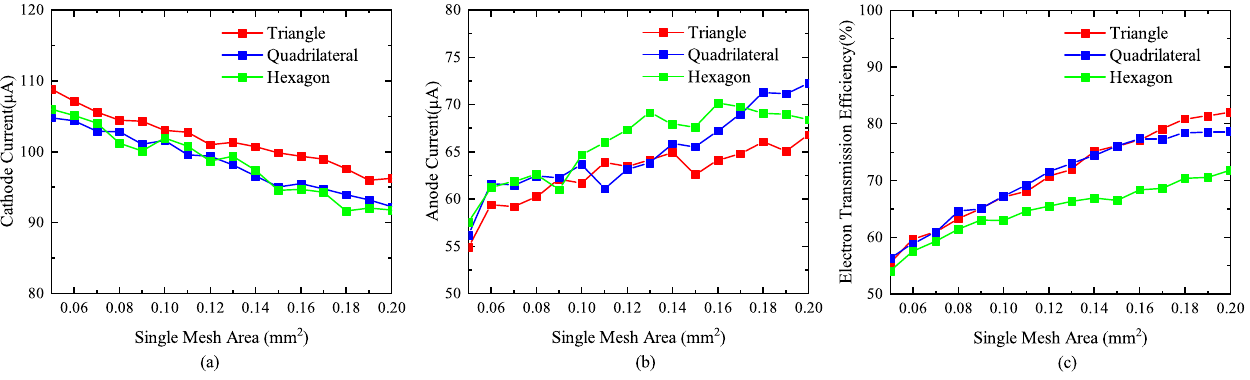
Figure 5. Relationship of single-grid-mesh area with cathode current, anode current, and electron transmission efficiency. ( a ) Effect of single-mesh area on cathode current. ( b ) Effect of single-mesh area on anode current. ( c ) Effect of single-mesh area on electron transmission